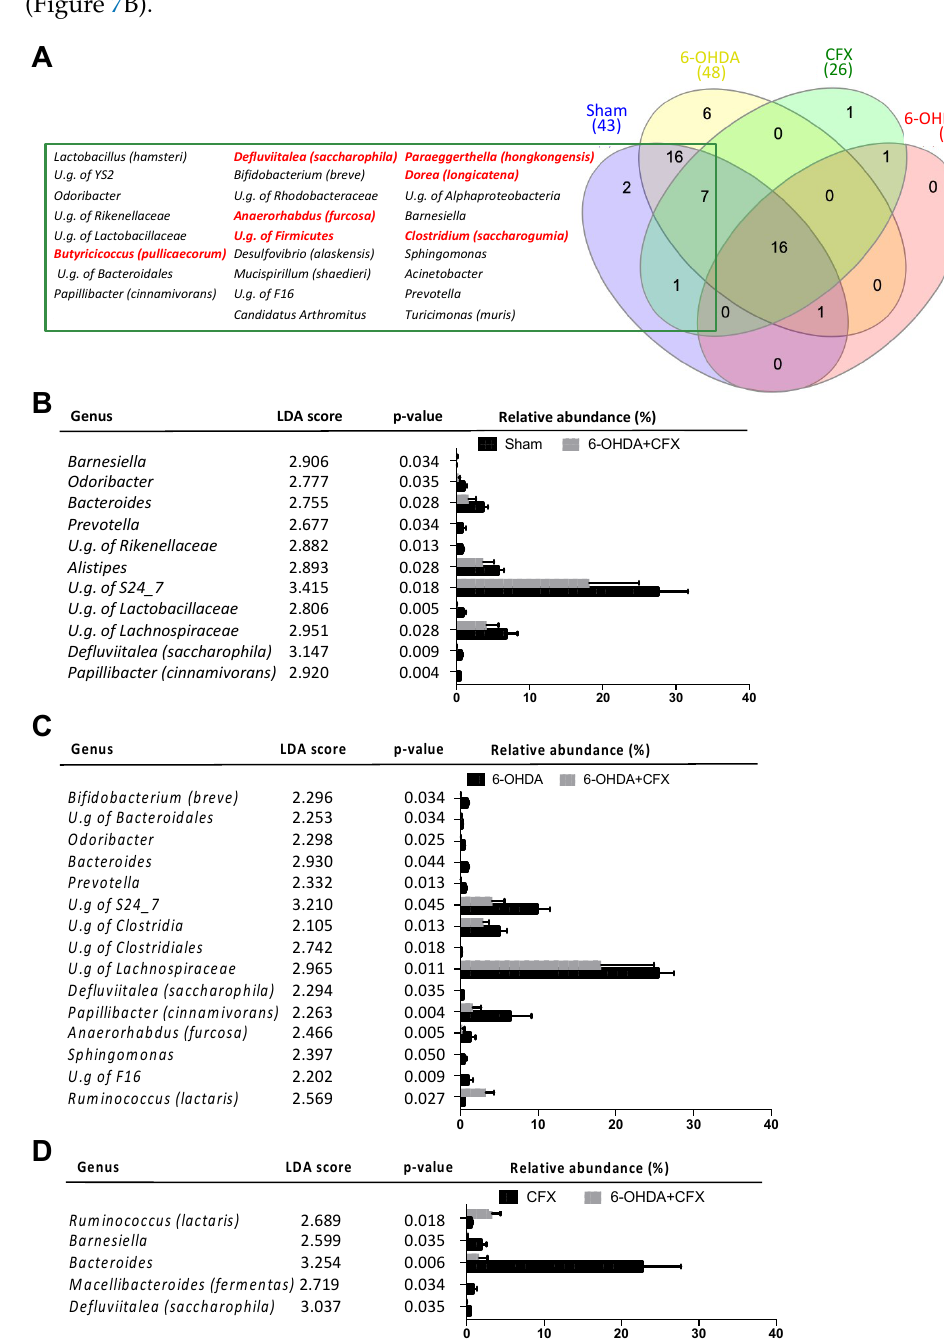
Figure 5. Antibiotic-induced dysbiosis in 6-OHDA-lesioned mice. ( A ) Venn diagram illustrating bacterial genera overlaps among core microbiomes with an attached list of the 26 genera missing in 6-OHDA+CFX to Sham group; in red are the 7 bacterial genera that specifically failed to recover in 6-OHDA+CFX. ( B – D ) Gut microbiota differences at genus taxonomic level based on linear discrimi- nant analysis (LDA) combined with effect size (LEfSe) algorithm ( p > 0.05 for both Kruskal–Wallis and pairwise Wilcoxon tests and a cutoff value of LDA score above 2.0). In each panel, LDA scores, p -values, and relative abundance of key genera discriminating bacterial communities are reported, when possible, and the species taxonomic classification/genus is also